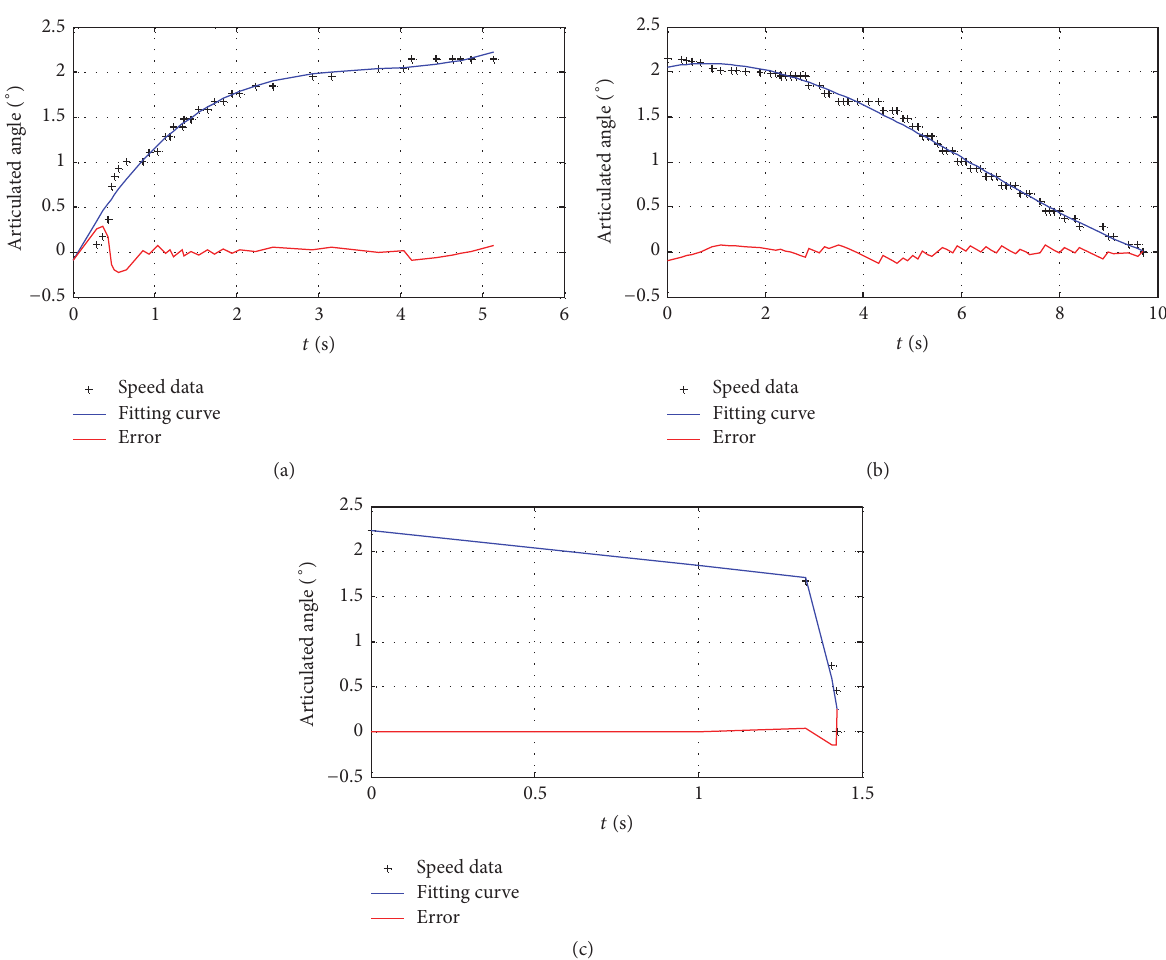
Figure 7: Fitting curves of different speed modes: (a) acceleration; (b) deceleration; and (c) braking.